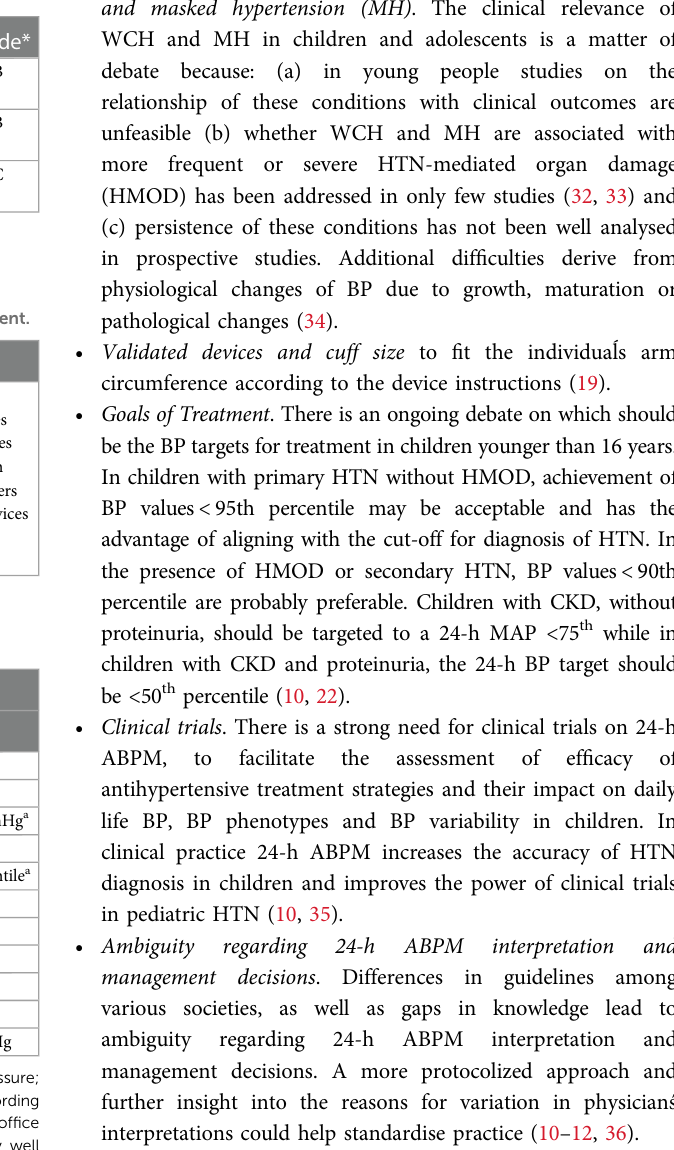
TABLE 2 Recommendations for high blood pressure screening at the of fi ce.